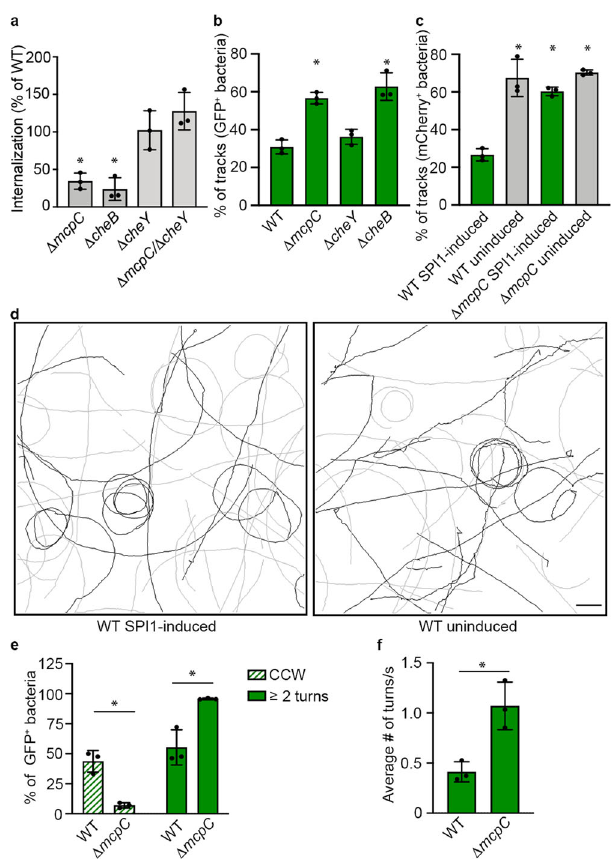
Fig. 6 McpC promotes CCW fl agellar rotational bias in SPI1-induced bacteria. a HeLa cells were infected with the indicated strains for 1.5 h